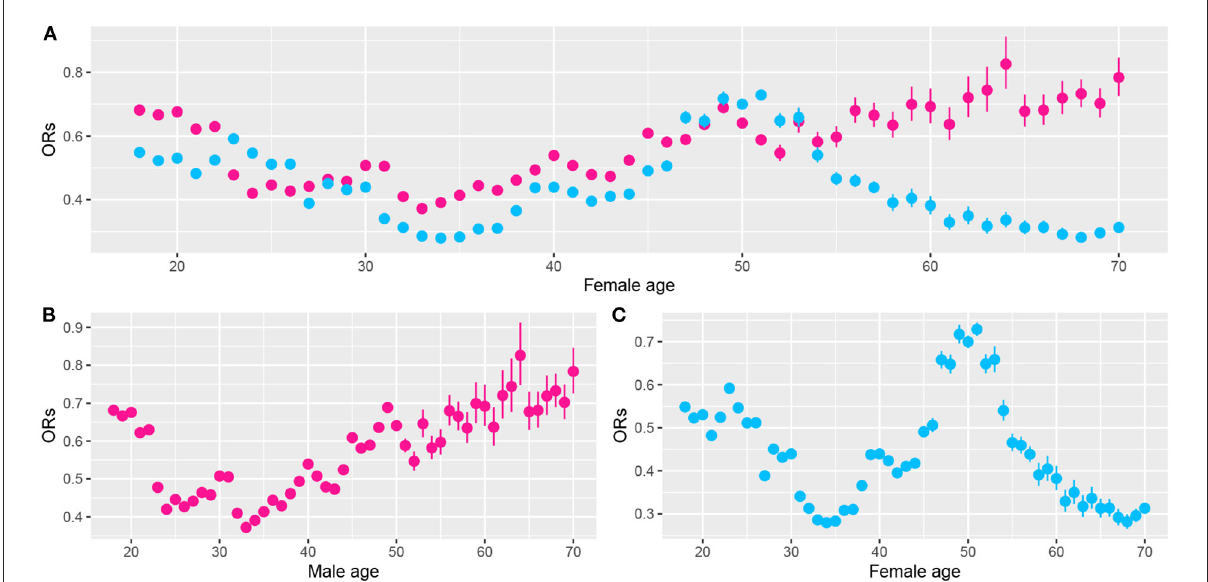
FIGURE5 Scatter plot of the odds ratios (ORs) calculated from female data (aged from 18 to 70) in a rolling window with a 15-year time interval. (B) ORs of women’s very short sleep for the second tertile of ALA intake. (C) ORs for the third tertile of ALA intake. (A) ORs for the second (pink) and the third tertile (sky-blue) of ALA intake. Models were adjusted for race, educational level, marital status, annual family income, BMI, caffeine intake, total energy intake, hypertension, diabetes, smoking status, drinking status, sedentary activity, and total activity per